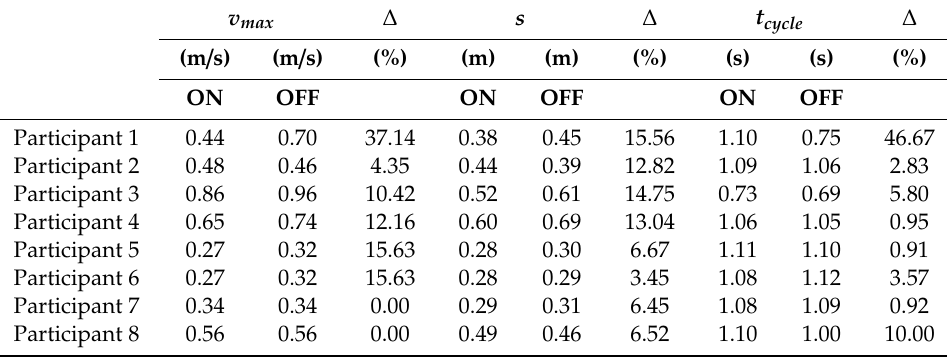
Table 3. The comparison of the average values of maximum velocity v max , of the roads, push phase duration time t cycle for respective participants. Where: ∆ —a percentage di ff erence between the parameter measured with the deactivated anti-rollback-system and the activated anti-rollback system, ON—activated anti-rollback system, OFF—deactivated anti-rollback system. v max ∆ s